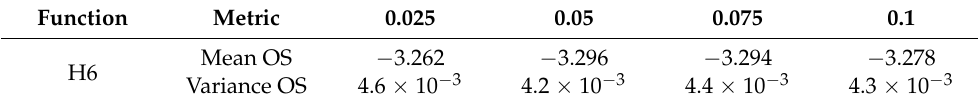
Table 5. Results of different in each iteration using the H6 function.